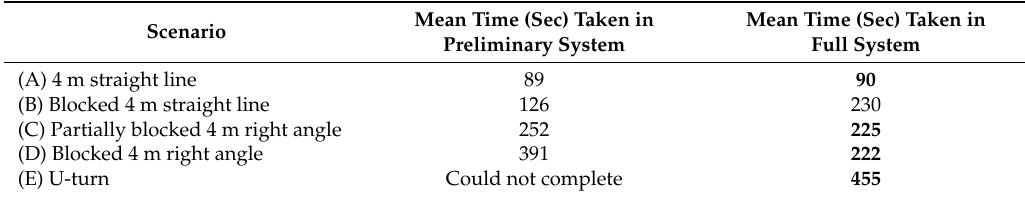
Table 1. Benchmark results, with the best result in each test